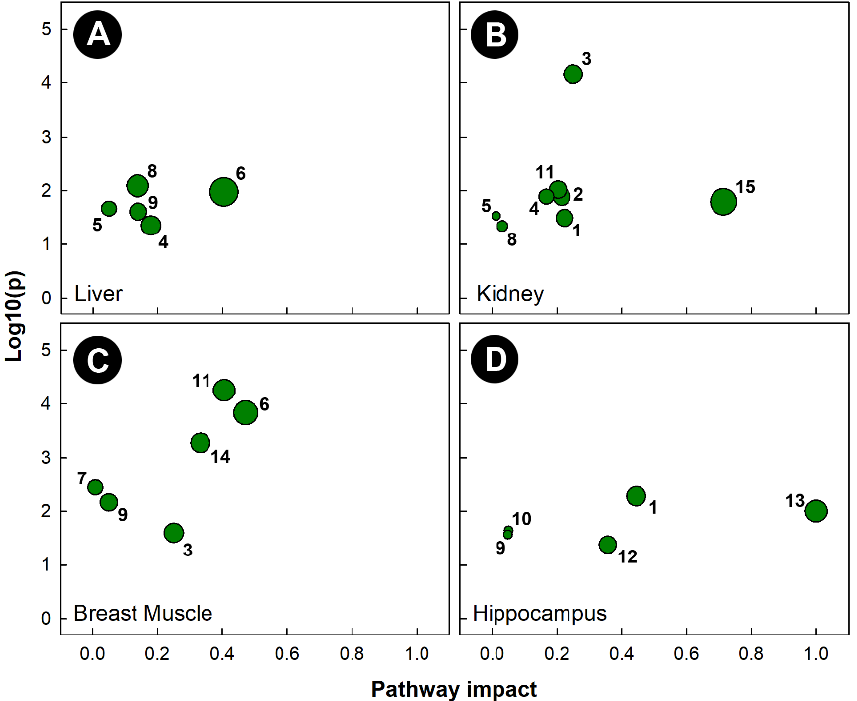
Figure 8. Pathway topologies of tissues from chicks subjected to isolation stress. ( A ) Liver; ( B ) kidney; ( C ) breast muscle; and ( D ) hippocampus. Pathways are: 1, alanine, aspartate, and glutamate metabolism; 2, amino sugar and nucleotide sugar metabolism; 3, ascorbate and aldarate metabolism; 4, citrate cycle (TCA cycle); 5, galactose metabolism; 6, glycine, serine, and threonine metabolism; 7, glycolysis/gluconeogenesis; 8, glyoxylate and dicarboxylate metabolism; 9, histidine metabolism; 10, nicotinate and nicotinamide metabolism; 11, pentose and glucuronate interconversions; 12, phenylalanine metabolism; 13, phenylalanine, tyrosine, and tryptophan biosynthesis; 14, starch and sucrose metabolism; and 15, taurine and hypotaurine metabolism. See Figure 6 for a description of the analysis tools used.